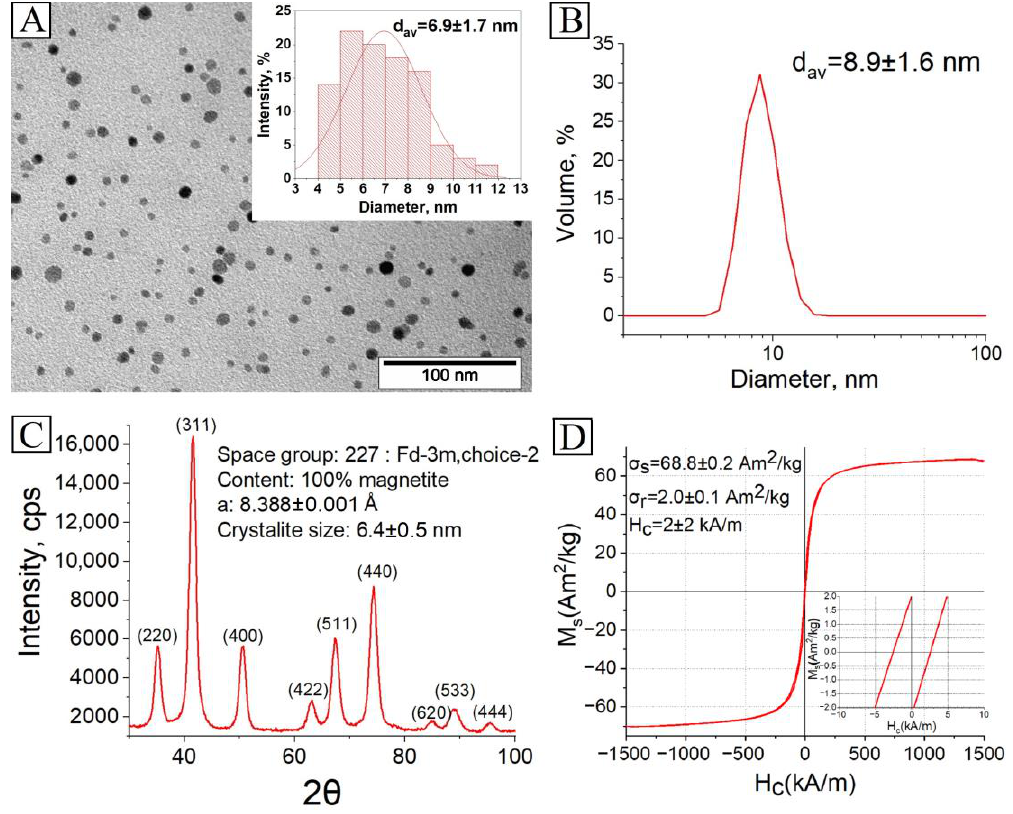
Figure 2. Characterization of the synthesized MNP: ( A ) TEM image and size distribution; ( B ) Size distribution by DLS of as-synthesized nanoparticles; ( C ) XRD spectrum; ( D ) Magnetic hysteresis loop.